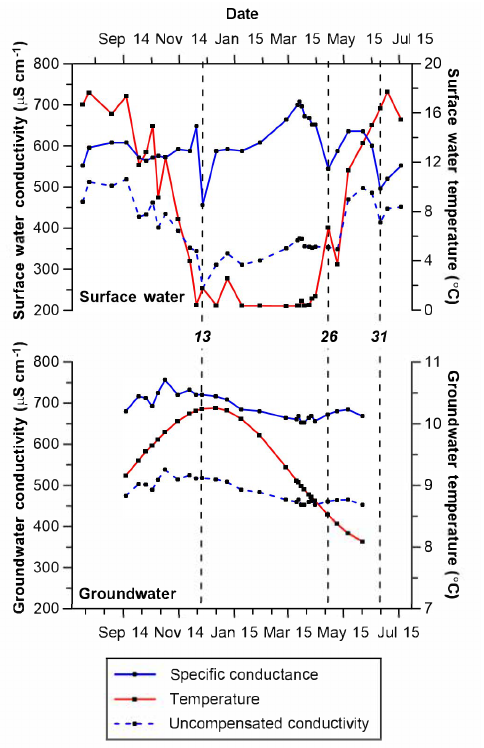
Figure 6. Specific conductance, temperature, and uncompensated aqueous conductivity of surface water at RSG4 and groundwater at the bottom of SCV6 (10.5mb.g.s.). Uncompensated conduc- tivity represents the actual conductivity of the porewater after re- incorporating the effect of temperature using the sensor’s internal temperature–conductivity correction factor.